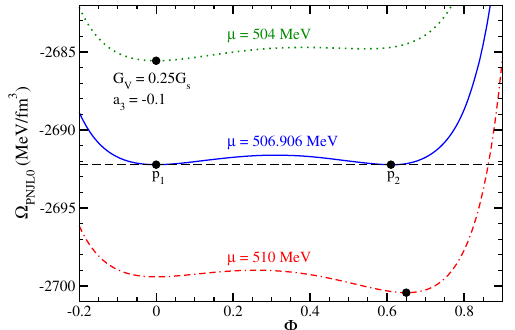
Fig. 4 Ω PNJL0 as a function of Φ for different μ values. Curves con- structed for G V = 0 . 25 G s and a 3 = − 0 . 1